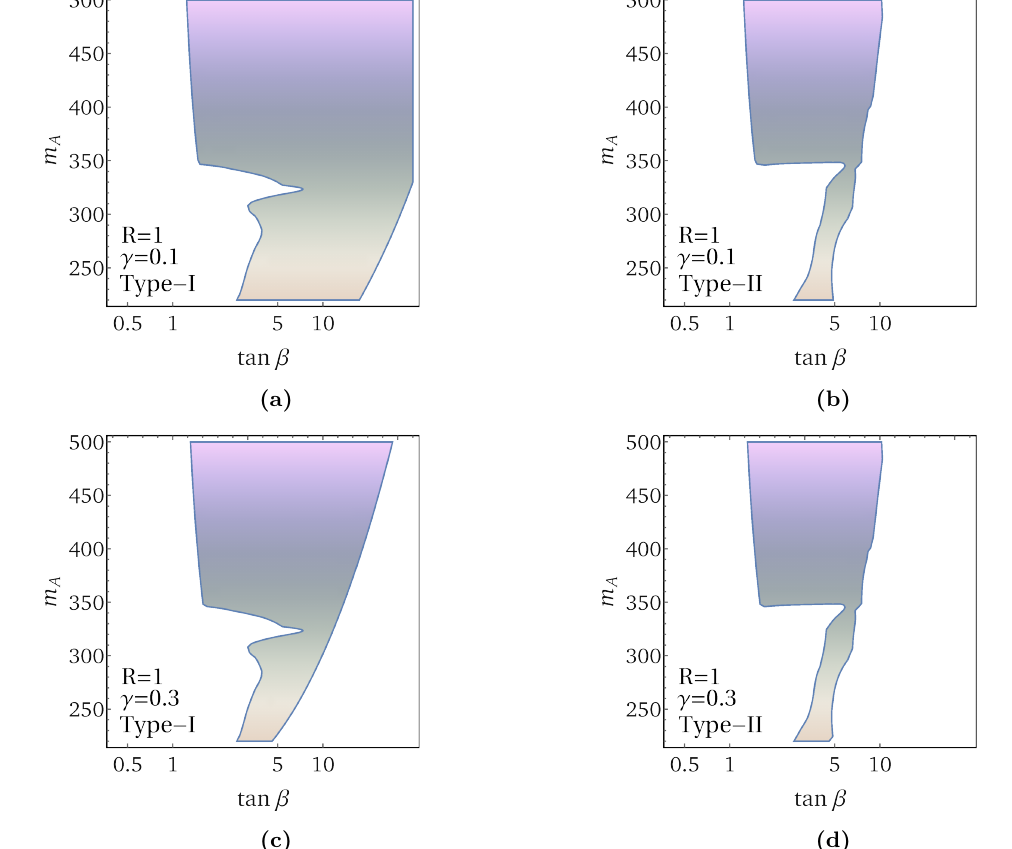
Figure 7. Experimental and tuning bounds for the softly-broken SO(3) -symmetric 2HDM ( R = 1 ). The shaded regions in panels (a) and (b) satisfy all experimental bounds in addition to having a tuning of at most 5% for both ∆ m 2 and m 2 in panels (c) and (d). Panels (a) and (c) correspond to 12 Type-I Yukawa couplings, and panels (b) and (d) correspond to Type-II Yukawa couplings. Panels (a) and (b) employ the γ = 0 . 1 benchmark, whereas panels (c) and (d) employ γ = 0 . 3